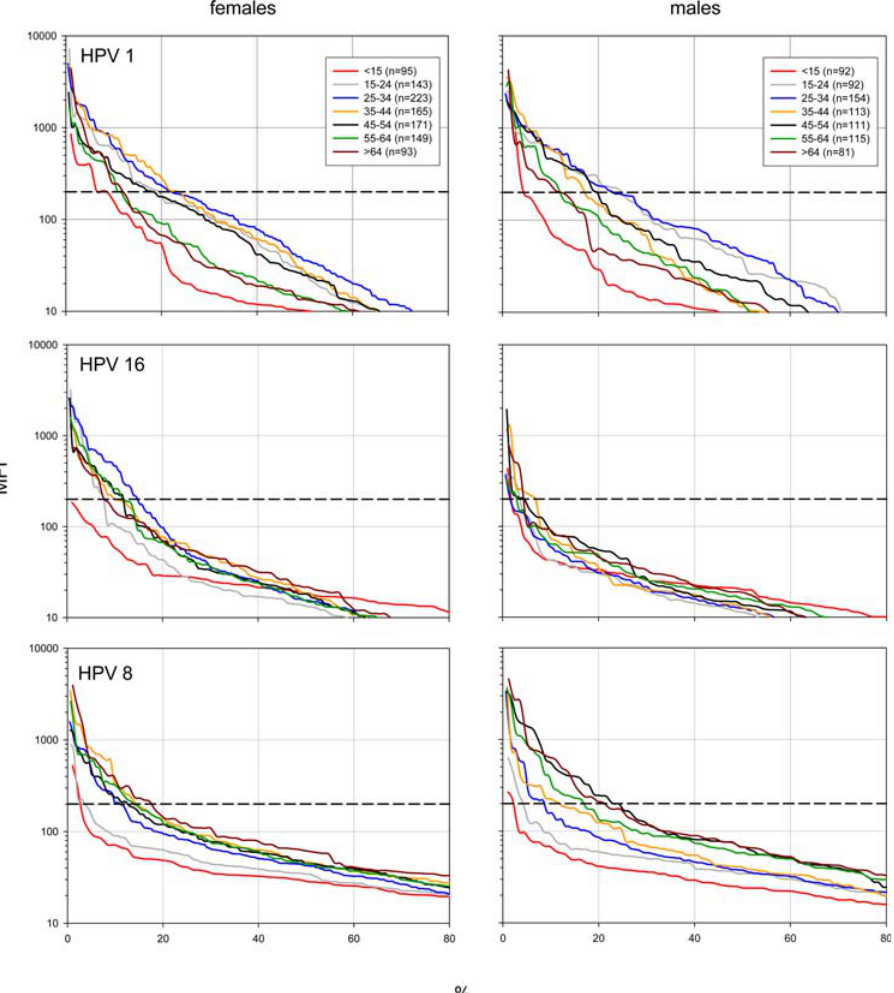
Figure 1. Distribution of antibody reactivity for HPV types 1, 16 and 8 in the German population. Antibodies against HPV L1 proteins were analysed in 1797 sera from the German general population and stratified by sex and age. The strength of the antibody reactions expressed as median fluorescence intensity (MFI) on the y-axis is plotted against the percentile on the x-axis. Data points were connected by spline curves. Colour code, age groups in years and size of the groups are indicated in the inserts. Dashed black lines indicate the cut-off of 200 MFI. The figure reads as follows (upper left panel, HPV 1 antibodies among females): In the 45–54 years age group, approximately 40% showed antibody reactions above 50 MFI, approximately 30% above 100 MFI, and approximately 20% above 200 MFI. For all HPV types and in both genders antibody reactivity was lowest in children. The biggest difference in antibody reactivity was observed between children and young adults (15–24 years) against HPV 1. In comparison to children, antibody levels against HPV 16 were substantially higher in young women but not in men. Antibody reactivity to HPV 8 became stronger with age in both genders and peaked in women at about 40 years and in men at about 50 years. Especially among men, a second peak was found in the oldest age group. These antibody patterns were present also for weak responses well below the chosen